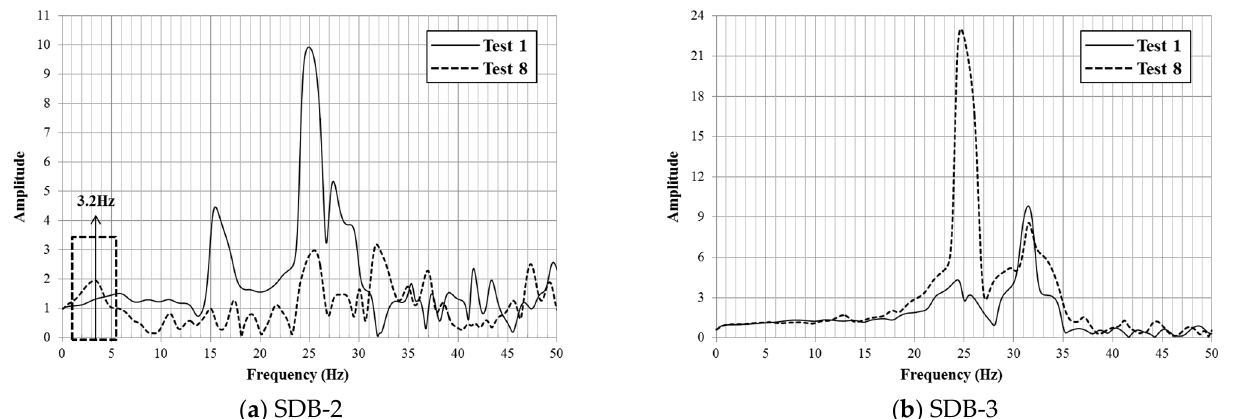
Figure 12. Natural frequency confirmed by the transfer function in Test 1 and Test 8: ( a ) A1 to A9, SDB-2, y-direction; ( b ) A1 to A9, SDB-3, y-direction.